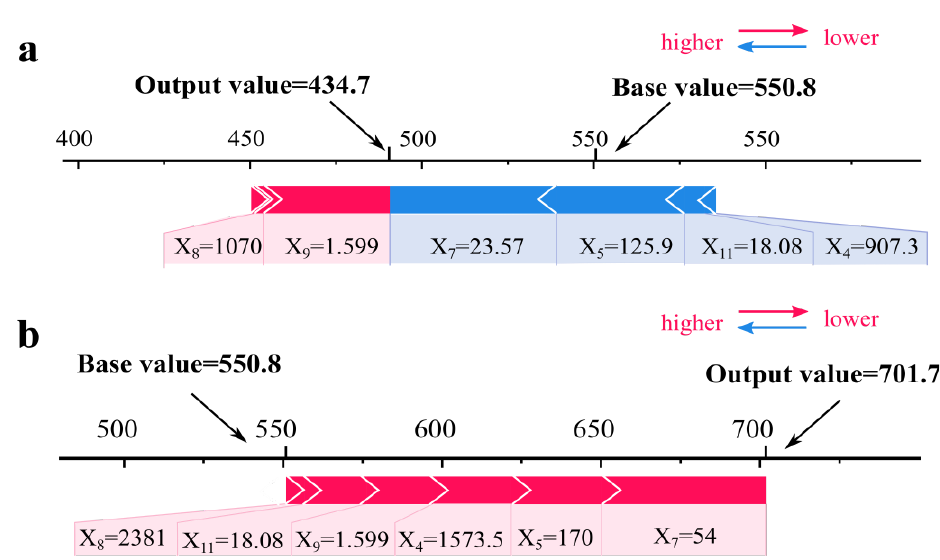
Figure 7. Evaluation results of factors based on SHAP values. (a) The prediction of point V9 on 30 March 2016; (b) The prediction of point V10 on 30 March 2016. A redder color represents a larger impact factor, and a bluer color represents a smaller impact factor.